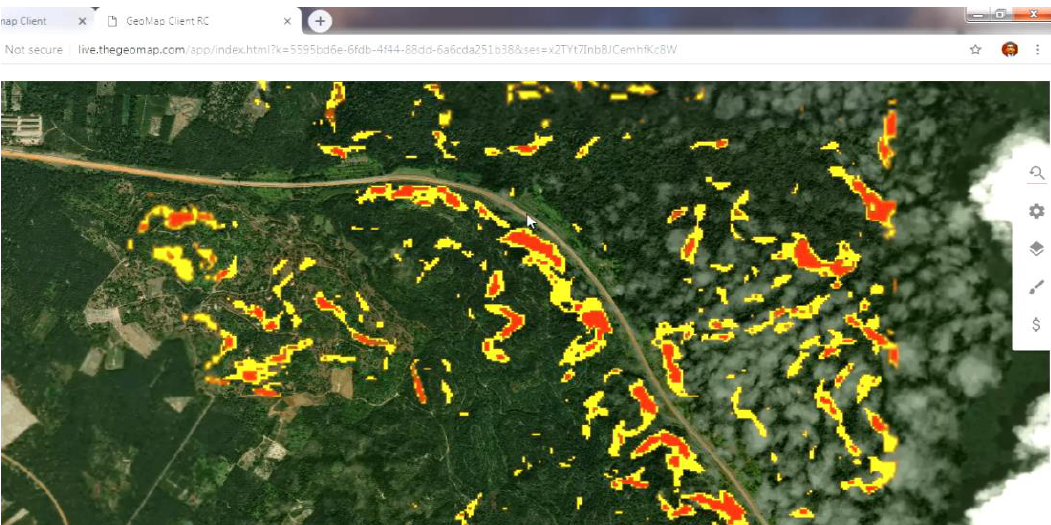
Figure 20: Example of GeoMap online viewer (vector dataset shared in a potential local authority DCP group) based on SDI concepts and enabling collaborative GIS architecture system (Figure 14 and 15).